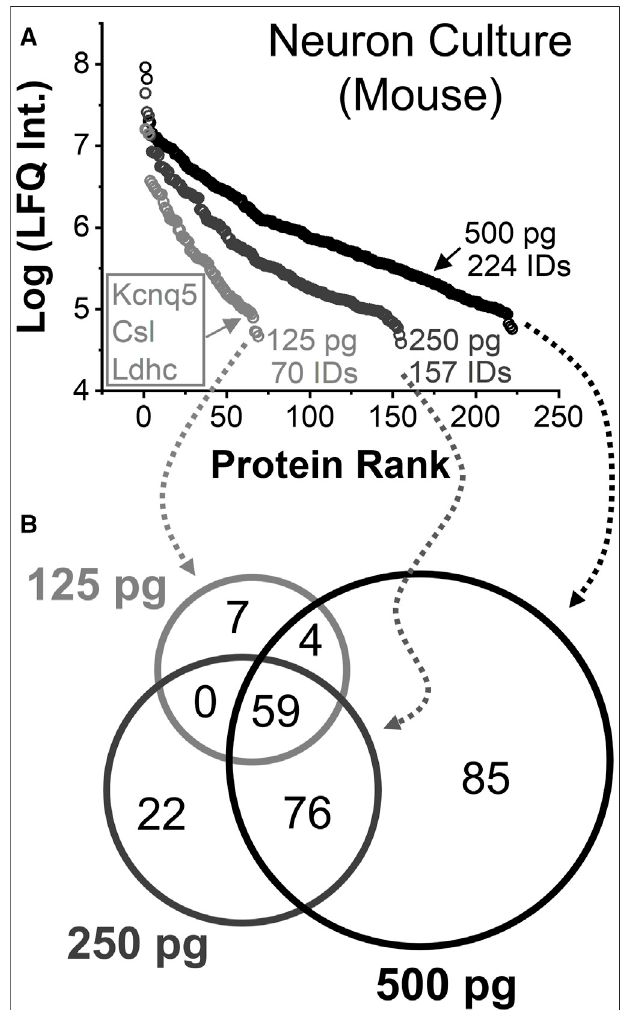
FIGURE 4 | Single-to-subcellular neuroproteomics by CE-HRMS. (A) Comparison of the linear dynamic range and depth of the quanti fi ed neuroproteome from diluted proteome digestsestimating to asingle neuron (~500 pg protein digest), a half neuron (~250 pg), and quarter of a neuron (~125 pg). (B) Comparison of proteins identi fi ed from the diluted